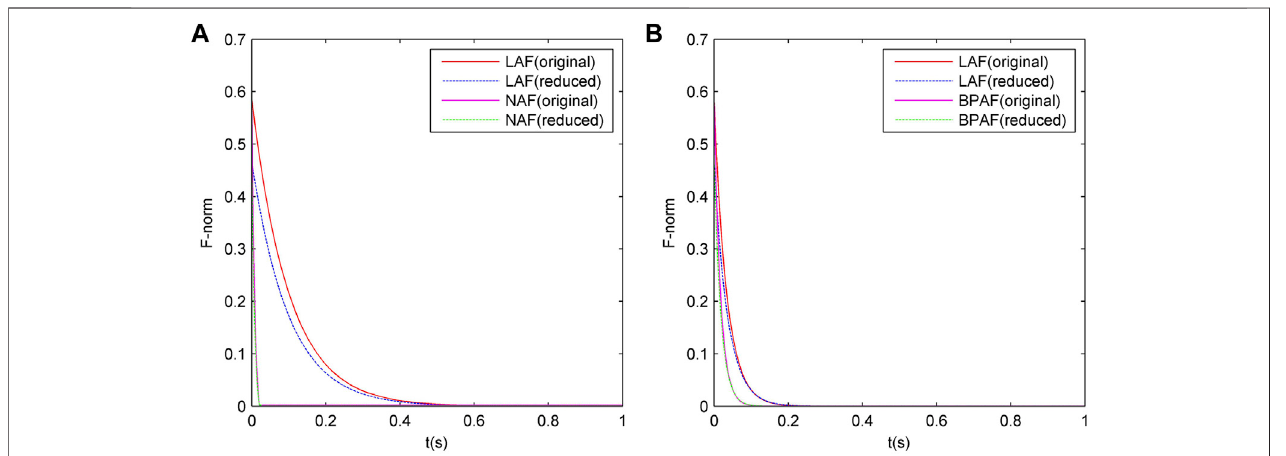
FIGURE 4 | Comparison of the convergence between the original-order and the reduced-order RNN models under Example 2. (A) is ZNN, (B) is GNN.